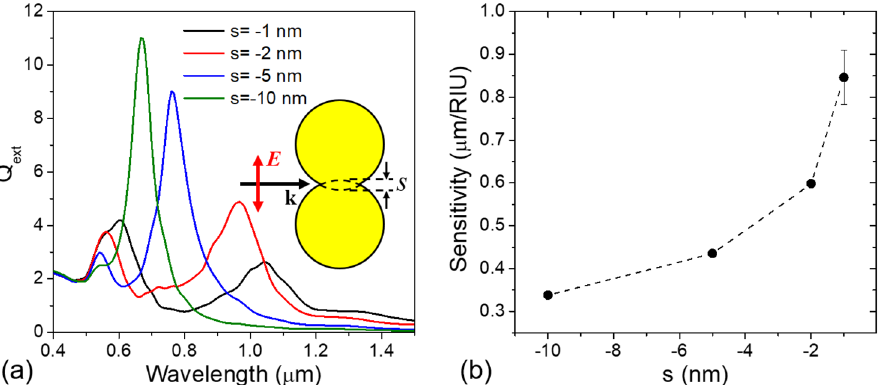
Figure 1. ( a ) Calculated extinction efficiency as a function of separation between the two identical Au spheres. Negative sign in the separation indicated the spheres are overlapped and merged. Inserted is the schematic configuration. ( b ) Dependence of the conductively coupled dimer’s sensitivity on the extent of